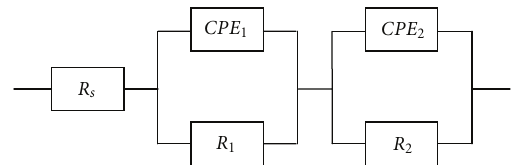
Figure 7: Equivalent electric circuit model used to fit the impedance data for treated and untreated galvanized